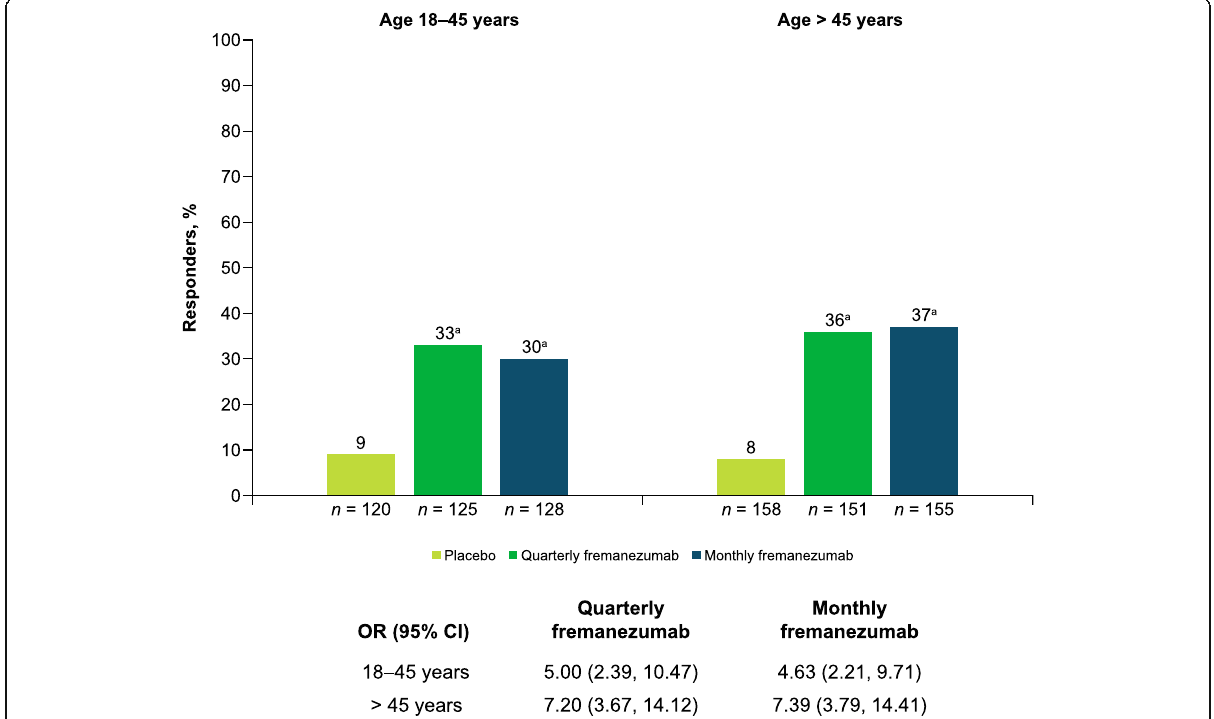
Fig. 2 Proportion of patients with ≥ 50% reduction in monthly migraine days from baseline during 12 weeks by age. CI, confidence interval; OR, odds ratio. a P < 0.001 vs placebo